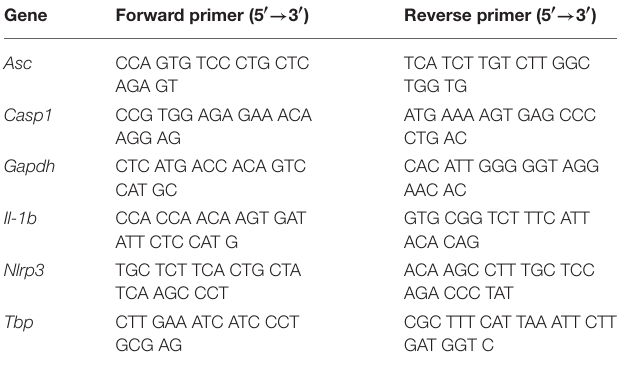
TABLE 1 | Gene specific primers for PCR and qRT-PCR analysis. Gene Forward primer (5 ′ → 3 ′